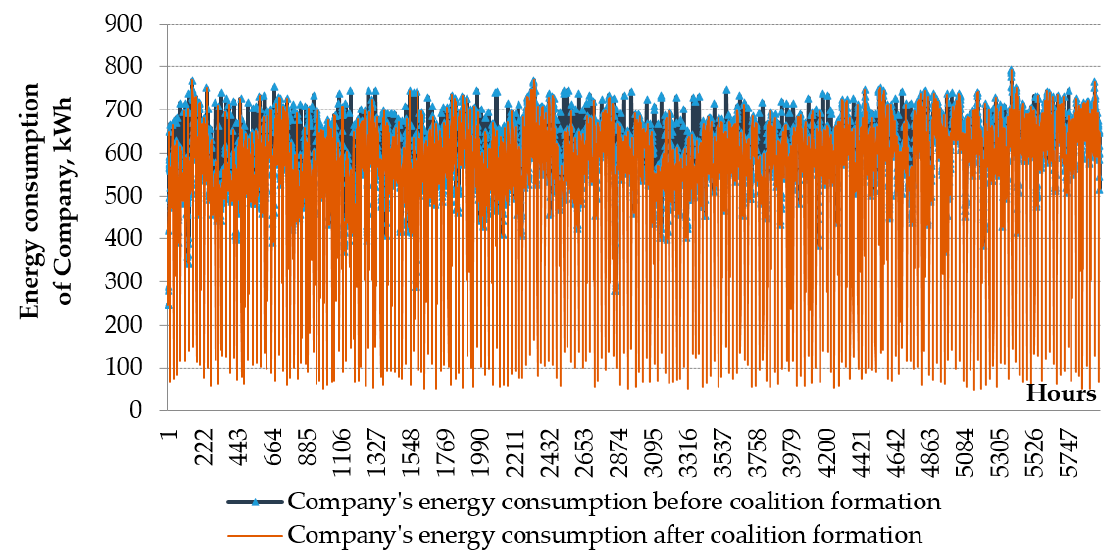
Figure 8. Annual energy consumption of the company, applying the new billing system.